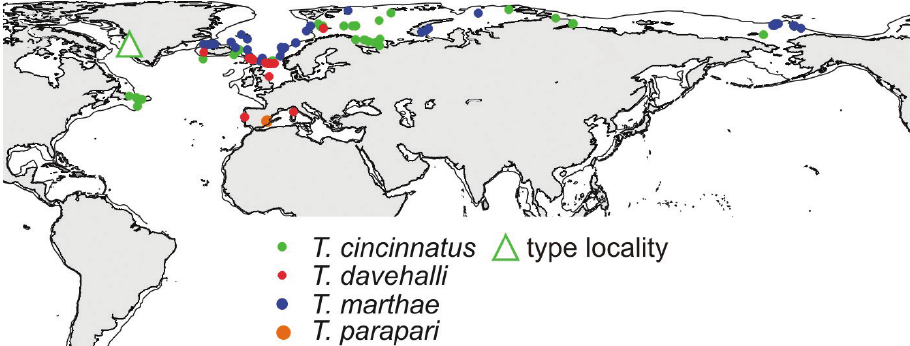
Figure 12. Map showing records of Thelepus. 500-m isobath is shown